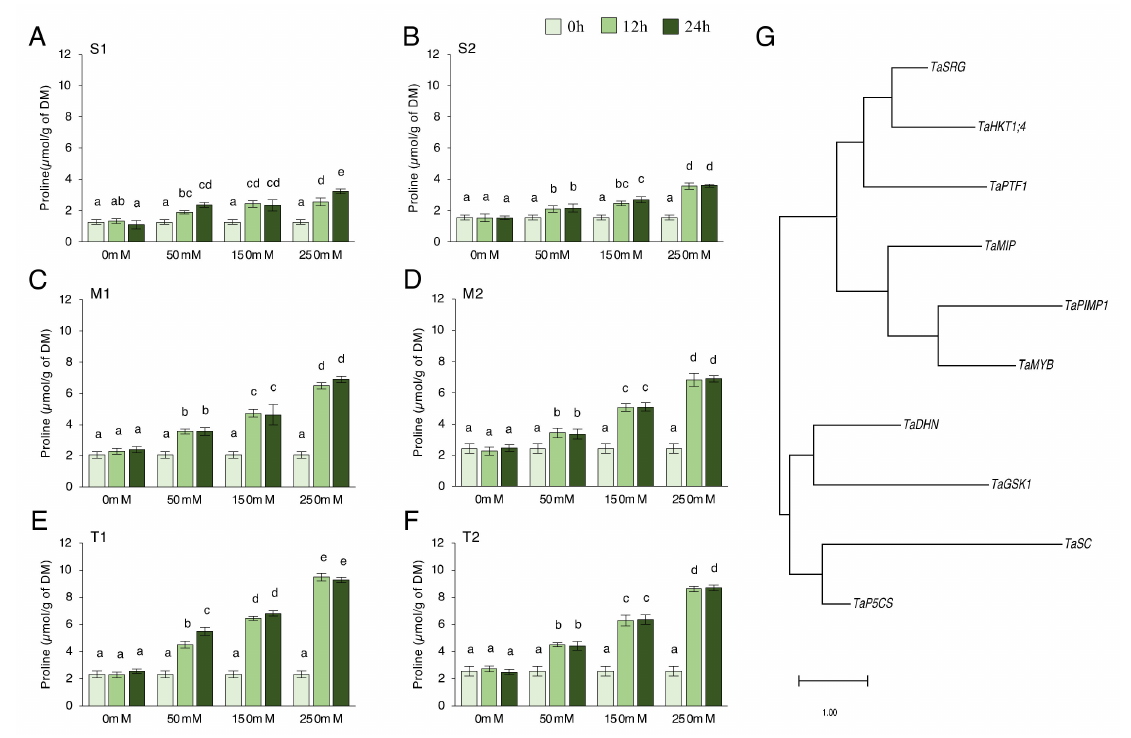
Figure 1. Proline content and phylogenetic tree of genes. ( A ) The proline content of the salt-sensitive-1 (S1), ( B ) sensitive-2 (S2), ( C ) moderate-1 (M1), ( D ) moderate-2 (M2), ( E ) tolerant-1 (T1), ( F ) tolerant-2 (T2), and ( G ) evolutionary phylogenetic tree of TaPTF1 , TaDHN , TaSRG , TaSC , TaPIMP1 , TaMIP , TaHKT1;4 , TaGSK , TaP5CS , and TaMYB genes by using amino acid sequences in MEGA 11.0.13 software. The proline content in S1, S2, M1, M2, T1, and T2 genotypes exposed to 0, 50, 150, and 250 mM NaCl stress for 0, 12, and 24 h. Means ( ± standard deviation) within the same graph followed by letters are significantly different at p < 0.05 according to the Tukey HSD test from independent biological triplicates ( n =